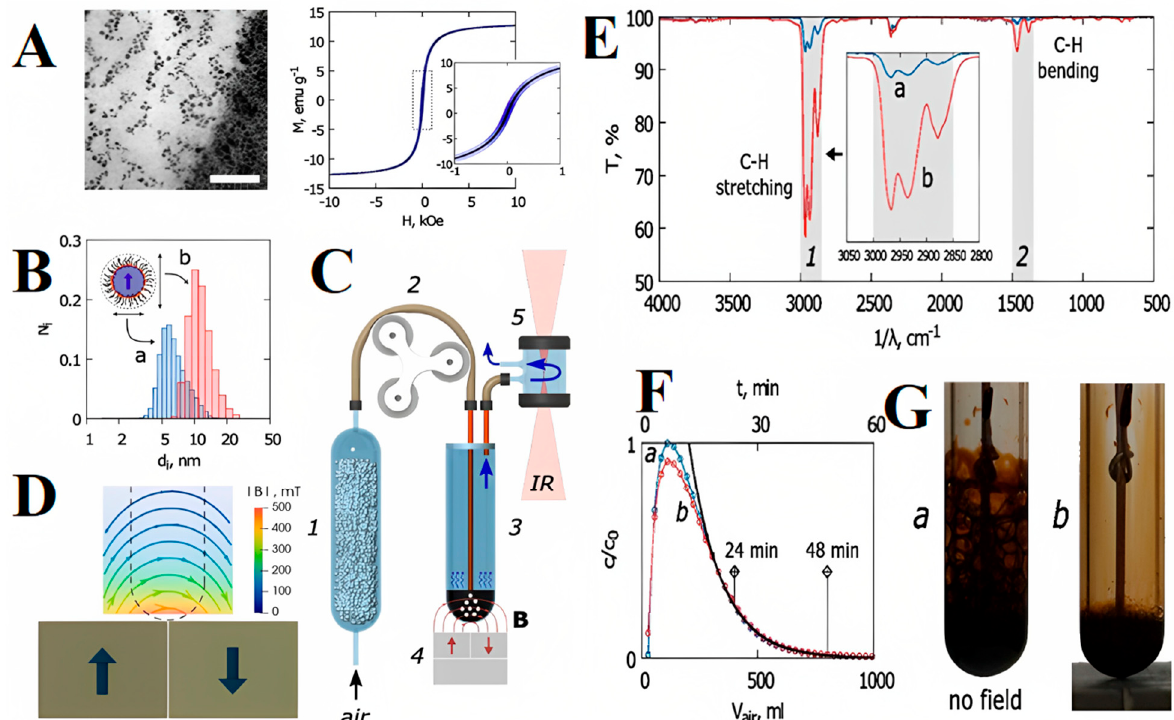
Figure 4. ( A ) Left: TEM image of FN sample (scale bar: 100 nm); right: magnetization curve of the FN sample; ( B ) size distribution ( a ) and hydrodynamic size ( b ) according to DLS analysis of Fe 3 O 4 core magnetic NPs; schematics of the ( C ) mass transfer experiment and ( D ) magnetic field control; ( E ) IR transmittance spectra of effluents obtained after the experiment; ( F ) the kinetics of the gaseous solute concentration (hexane) in the effluent estimated using an IR spectrometer in terms of volume of gas transported ( a ) in the absence of a magnetic field and ( b ) in the presence of a permanent magnet unit; ( G ) morphology of gas − liquid boundary during the mass transfer process. Reprinted with permission from Ref. [46]. Copyright 2020, Elsevier.